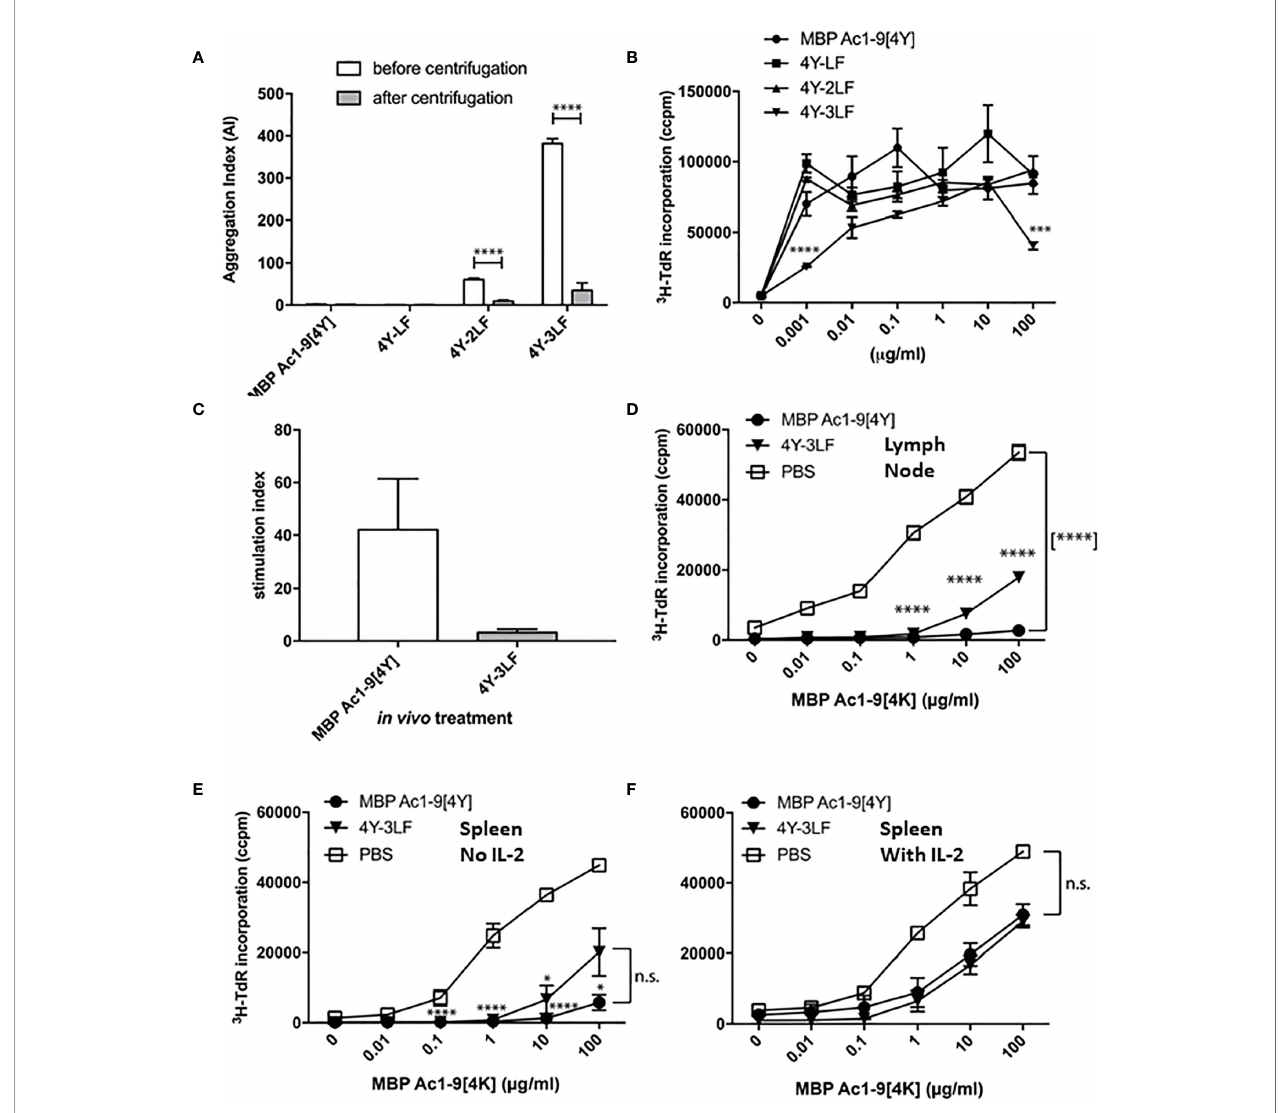
FIGURE 2 | Peptide solubility predicts accessibility to steady state DC and determines tolerance induction: The 4Y peptide was rendered increasingly insoluble by addition of LF motifs. Aggregation index (AI) calculated by the formula AI = 100 x (Abs340/(Abs280-Abs340). All bars show the mean and SEM of eight repeat measurements taken in a single experiment. (A) peptides with 2-3 LF motifs were increasingly aggregated but remained antigenic (B) as evidenced by tritiated thymidine ( 3 H-TdR) incorporation at d3 after addition to Tg4 splenocytes (2x10 5 per well) in vitro . (C) shows cell proliferation of Tg4 CD4 + T cells simulated in vitro with CD11c + cells puri fi ed from mice treated with 80µg 4Y or 4Y-3LF SC, as in Figure 1A . (D) Tg4 mice received escalating doses (see Figure 3E ) of 4Y ( fi lled circle), 4Y-3LF ( fi lled inverted triangle), or PBS (open square) injections SC every 3-4 days. Inguinal and brachial lymph nodes were isolated three days following the sixth dose and cultured at 5x10 4 cells per well in a 96 – well plate with Ac1 – 9[4K]. Proliferation was measured by tritiated thymidine ( 3 H-TdR) incorporation at 72 hours. Using the same conditions as in (D) , (E) analyses the response of 5x10 4 splenocytes per well without IL-2 or following addition of exogenous rhIL-2 at 20 U/ml (F) . Graphs show mean of triplicate wells and error bars show SEM (*p ≤ 0.05, **p ≤ 0.01, ***p ≤ 0.001, ****p ≤